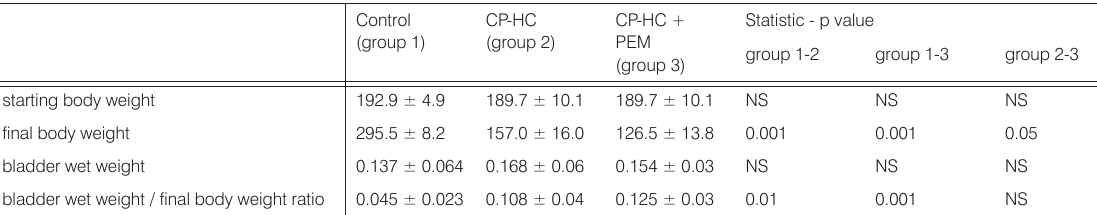
Table 1. The characteristics of study